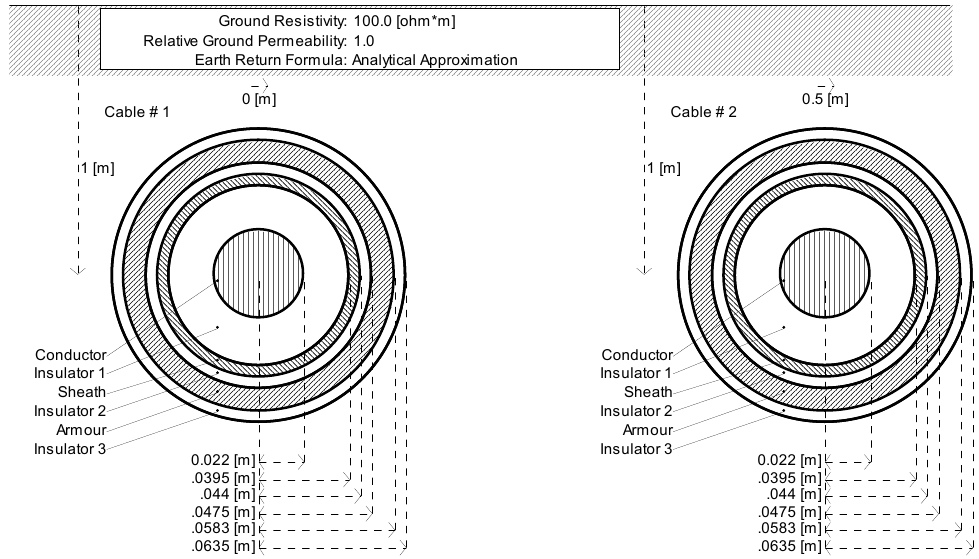
Figure 9. The structure of bipolar DC cable lines.